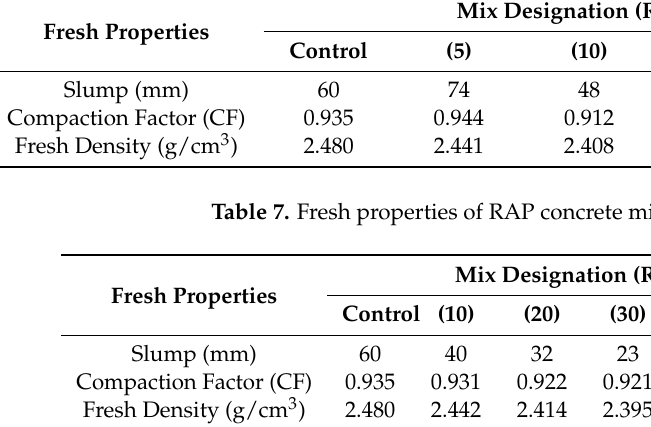
Table 7. Fresh properties of RAP concrete mixes. Table 8. Fresh properties of both RHA and RAP concrete mixes.